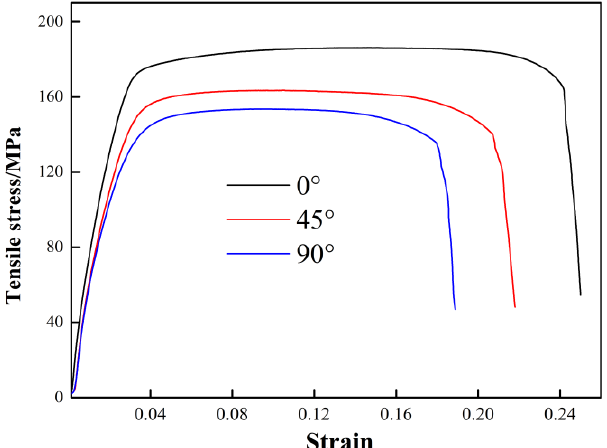
Figure 9. Stress-strain curves of the Ti/Al laminated composites obtained from the tensile test. Table 2. Mechanical properties of the Ti/Al laminated composites.